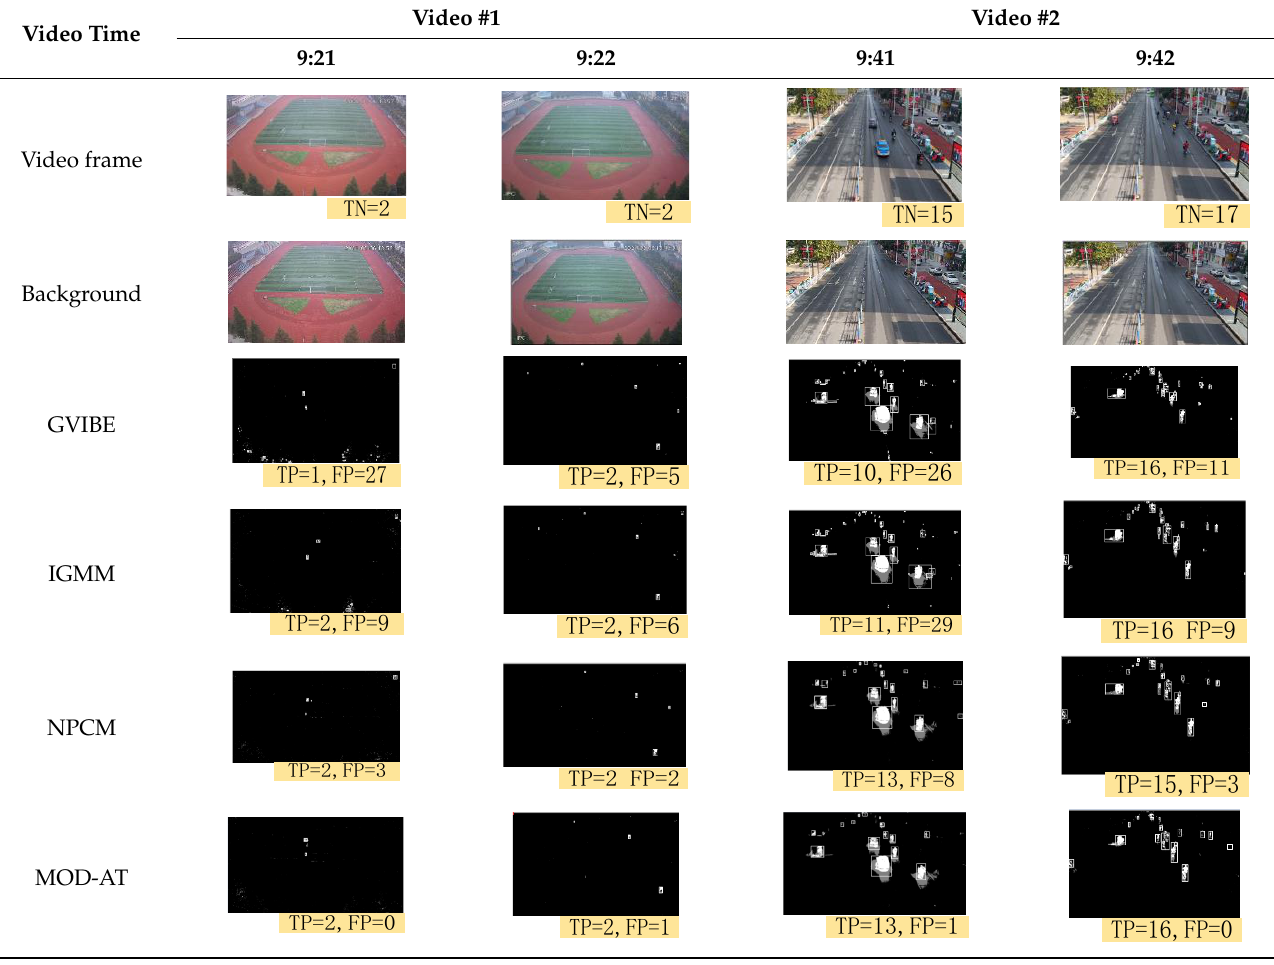
Figure 10. Experimental results of videos #1 and #2 for algorithm comparison: ( a ) comparison of number of correct detec- tions for video #1; ( b ) TP and TN error box charts of video #1; ( c ) comparison of number of correct detections for video #2; ( d ) TP and TN error box charts of video #2.